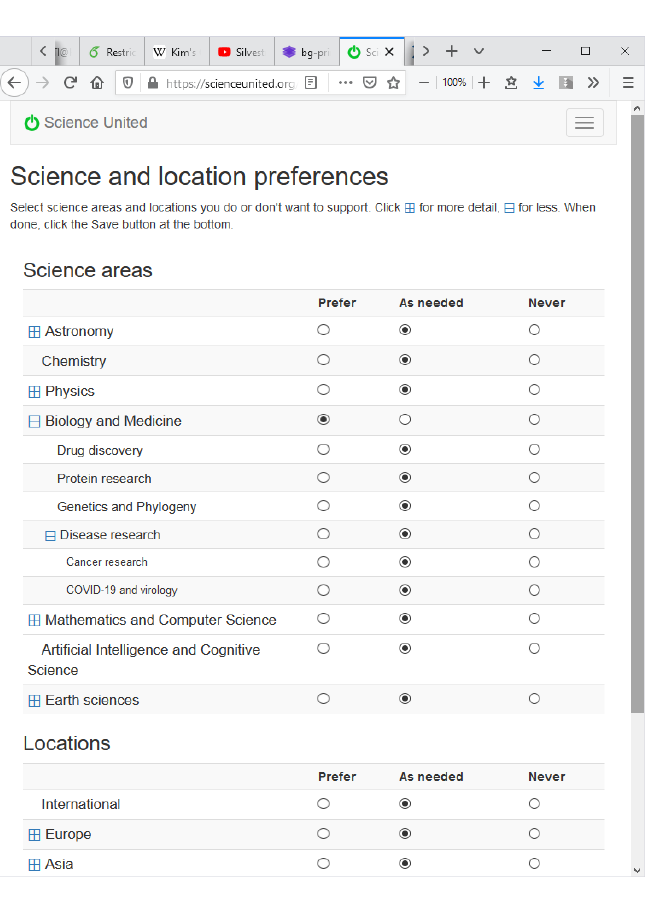
Figure 2. The Science United user interface for specifying preferences.